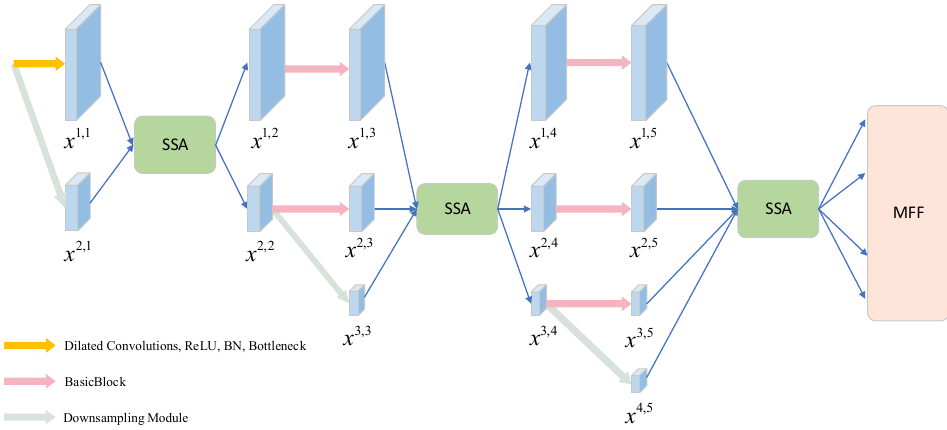
Figure 2. SFnet structure diagram. x m , n represents the feature map processed by the BottleNeck, BasicBlock or downsampling modules. The paired images at the same stage enter the SSA, and the features after the last layer of SSA are input into the MFF for feature